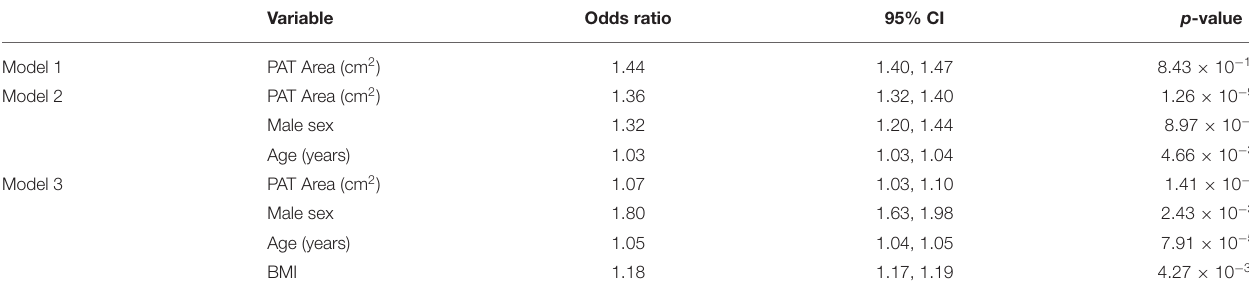
TABLE 2 | Logistic regression for prediction of diabetes in the UK Biobank